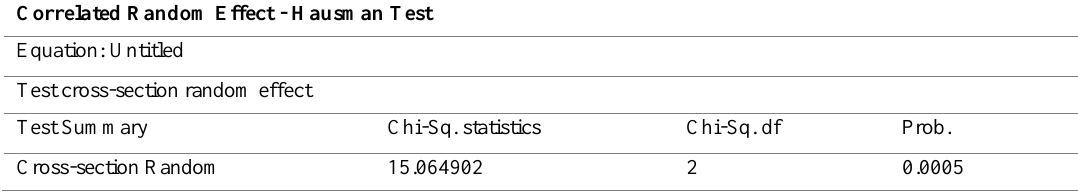
Table 8: Hausman test